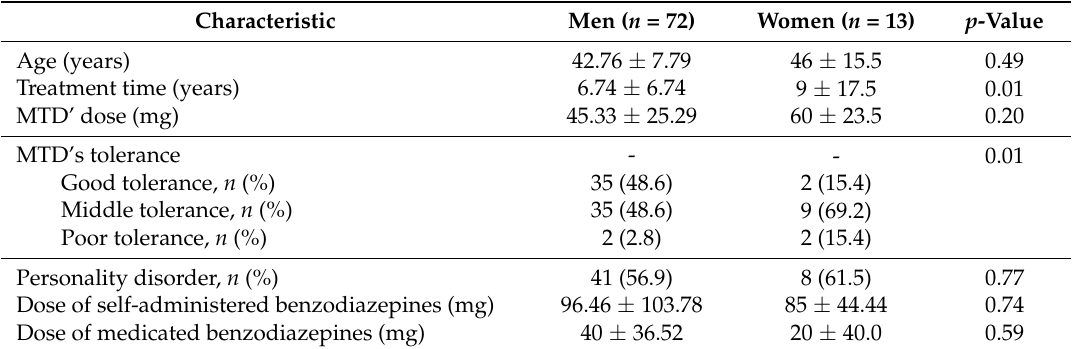
Table 2. Comparison of sexes in clinical and sociodemographic characteristics.